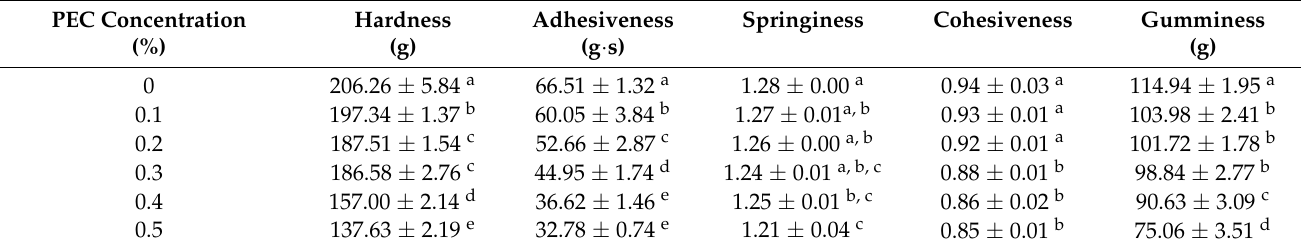
Table 4. Textural parameters of the WRS pastes with different pectin contents *. PEC Concentration